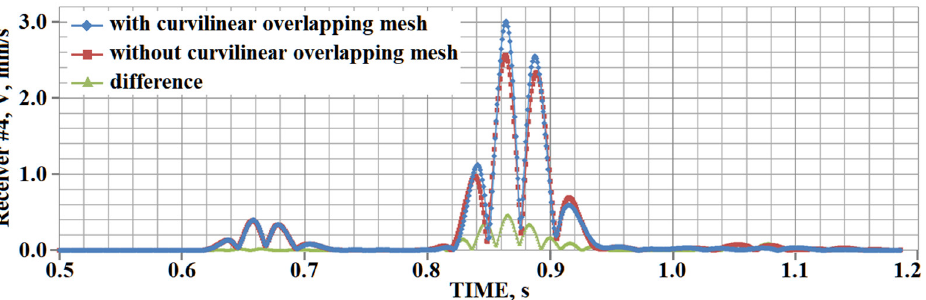
Figure 12. Receiver #4, dependencies of velocity modulus on time.